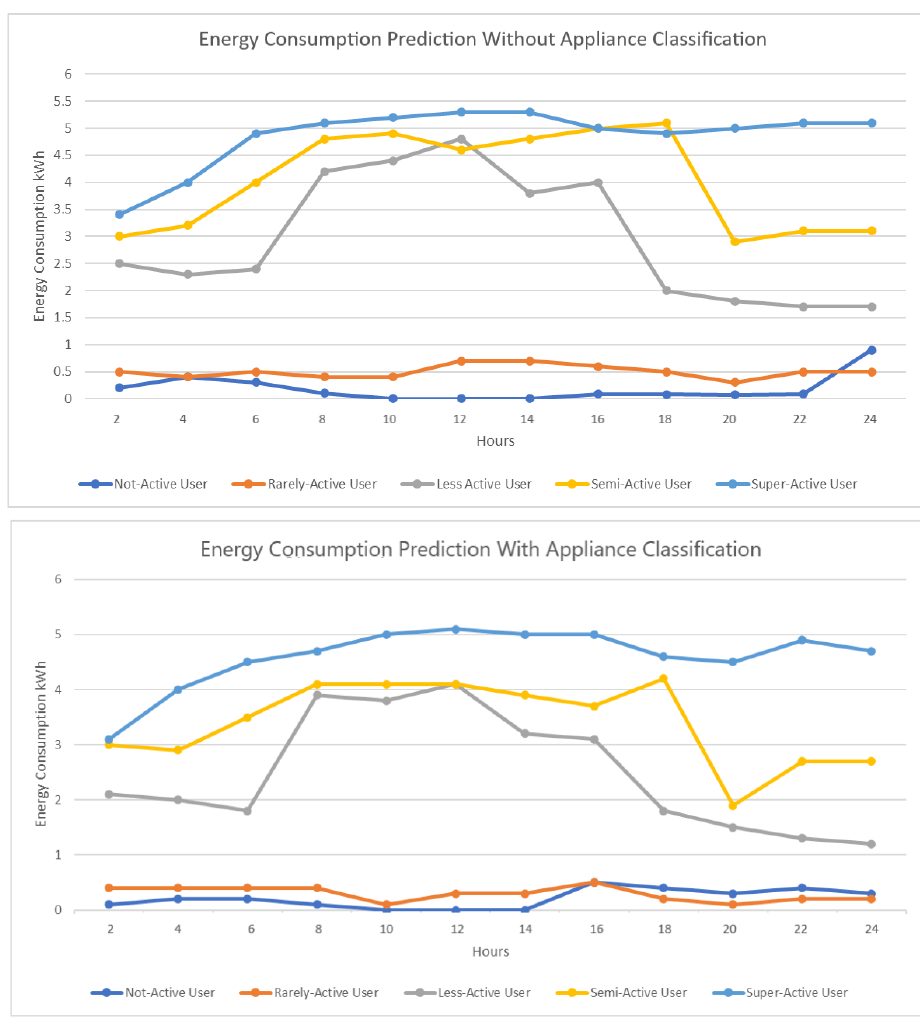
Figure 7. Energy consumption prediction without and with appliance